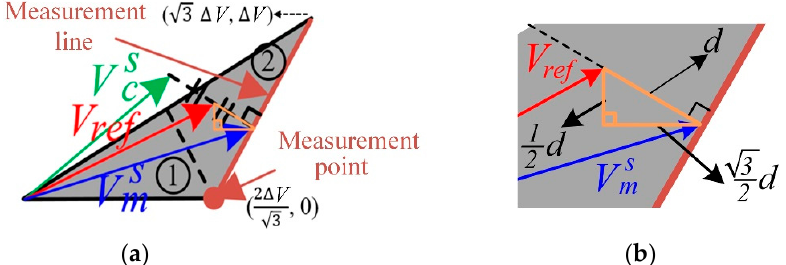
Figure 20. Optimal voltage injection method in Part.1_2. ( a ) Reference voltage vector on Part.1_2; ( b ) detailed view of the left one.